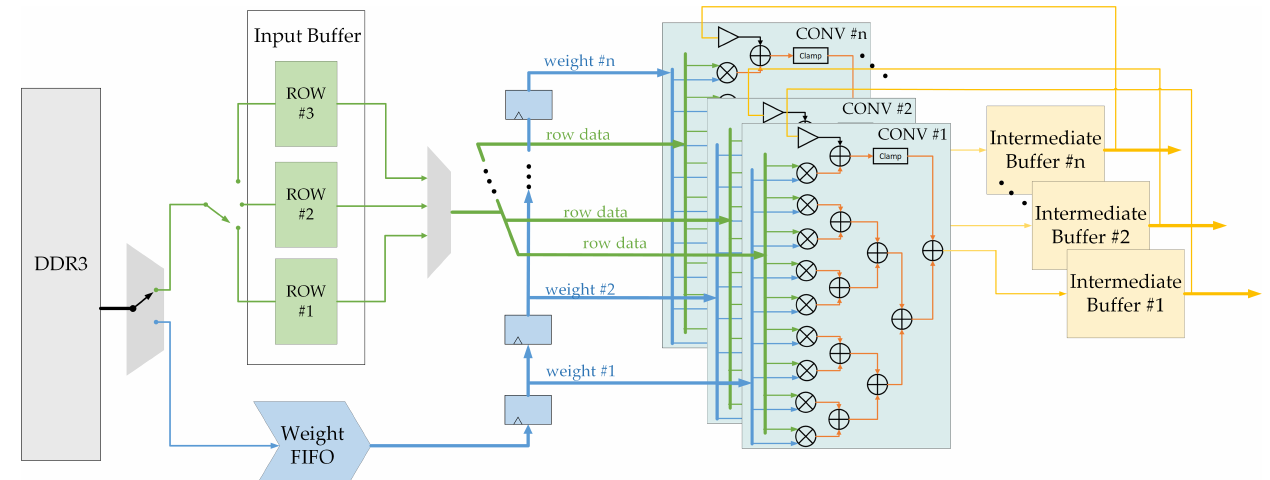
Figure 9. Convolutional computation